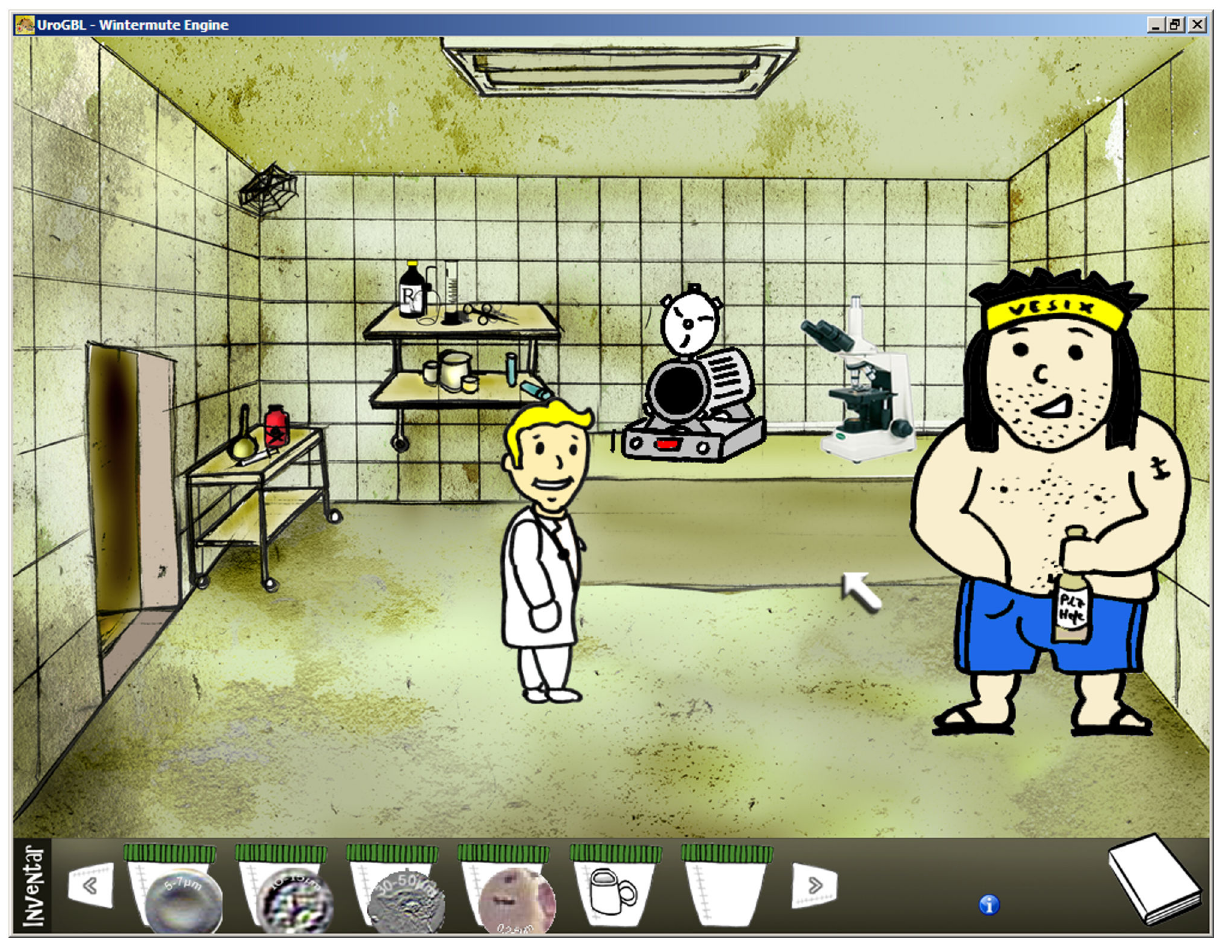
Figure 3. Scene from Uro-Island. The players' character together with Vesix in a laboratory. Different things like cells, cristalls and tools have been collected into the inventory. Later the character can use them together with the correct devices in the laboratory, e.g. the microscope or the autoclave, to proceed in the unfolding story of the game. doi: